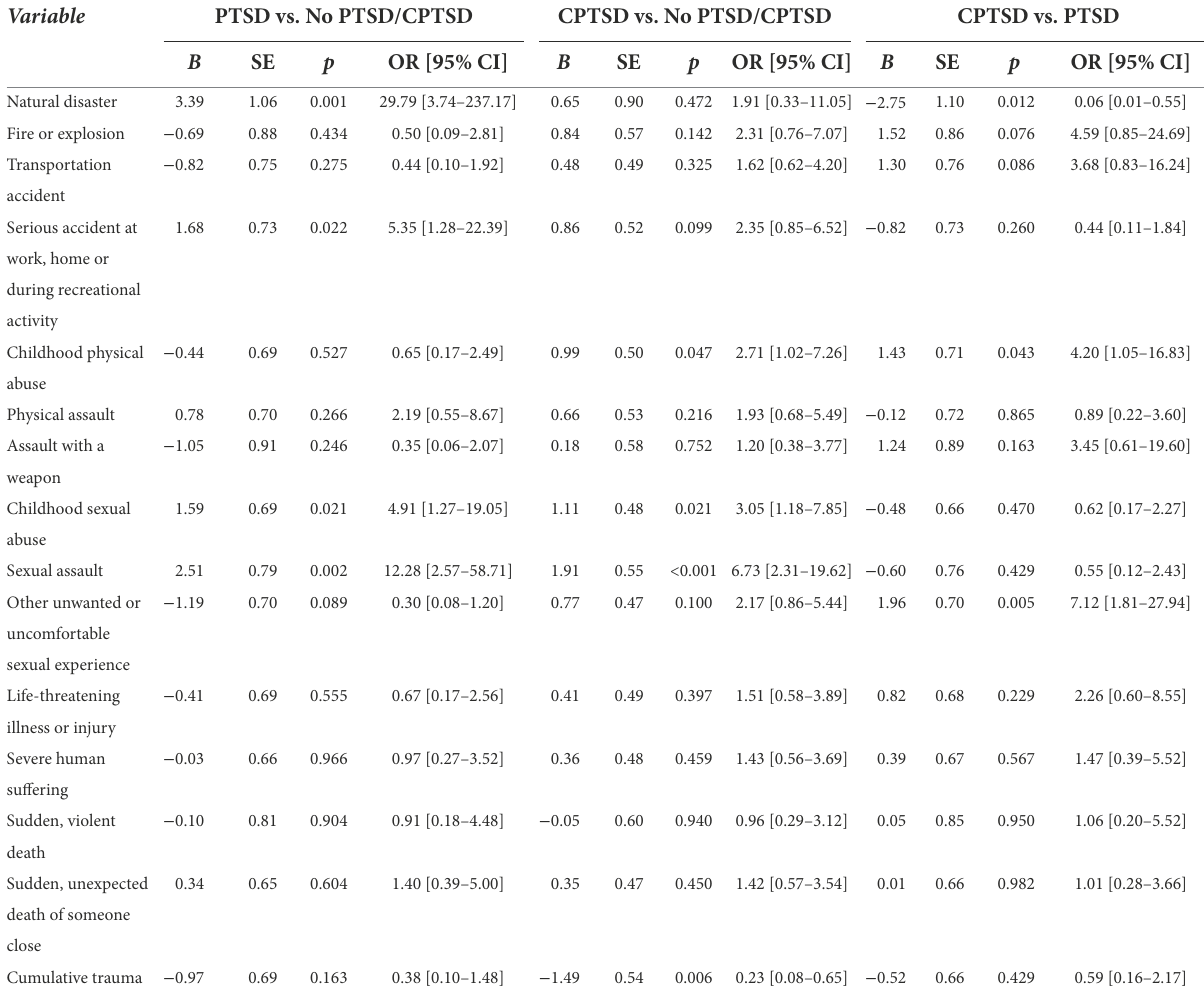
TABLE 2 Multinomial Logistic Regression for the prediction of risk for PTSD and CPTSD ( N = 157).